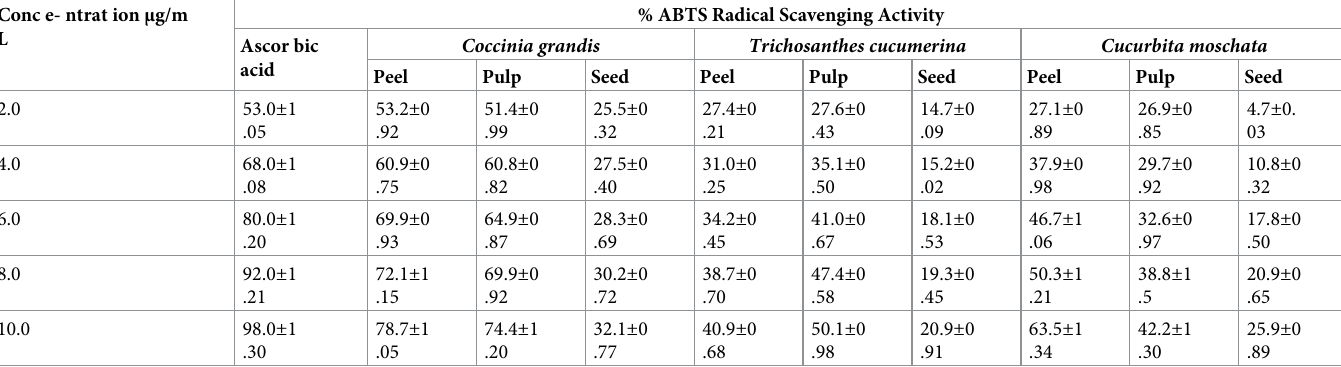
Table 3. Antioxidant activity of aqueous extracts of various parts of studied Cucurbitaceae vegetables evaluated by ABTS•+ radical scavenging